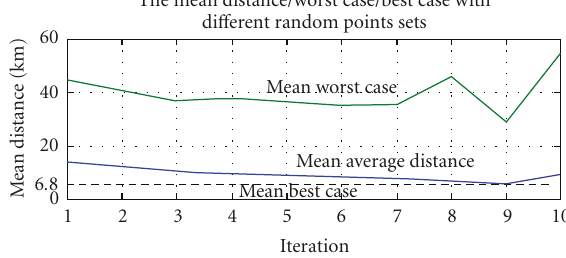
Figure 8: The mean distance/best case/worst case with di ff erent random points sets in small step size scheme.